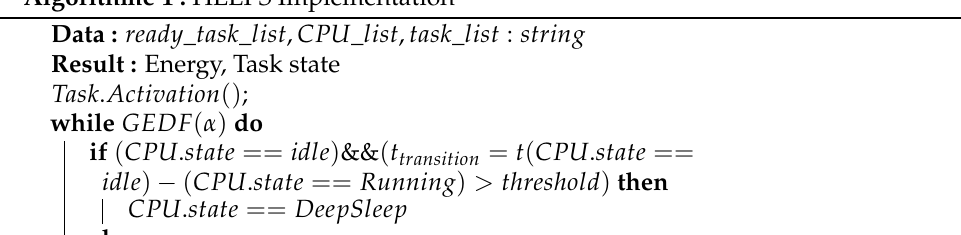
Algorithme 1 : HEEPS